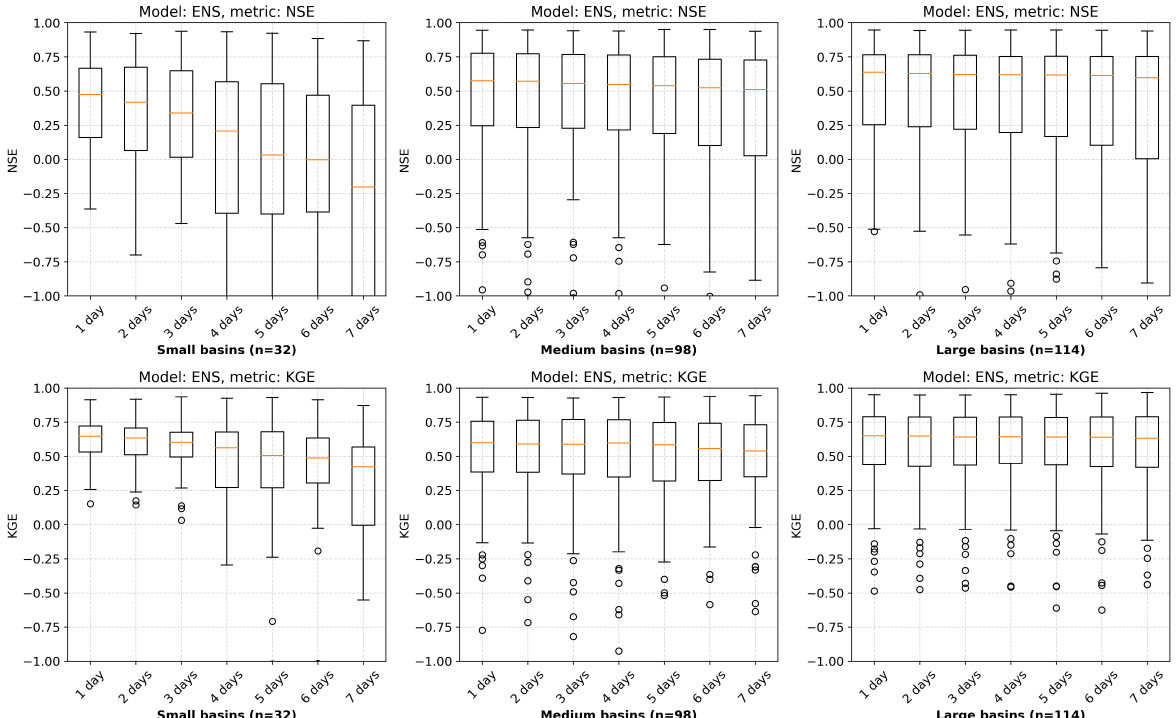
Figure 8. Verification of the ensemble mean forecast (ENS) in terms of NSE (top row) and KGE (bottom row) for the three groups of river basins: small (left column), medium (middle column), and large (right column). The boxplot box represents the Interquartile Range (IQR, the difference between the 25th and 75th quantiles); the whiskers represent ± 1.5 × IQR from the 25th and 75th quantiles, respectively; the yellow line denotes the median